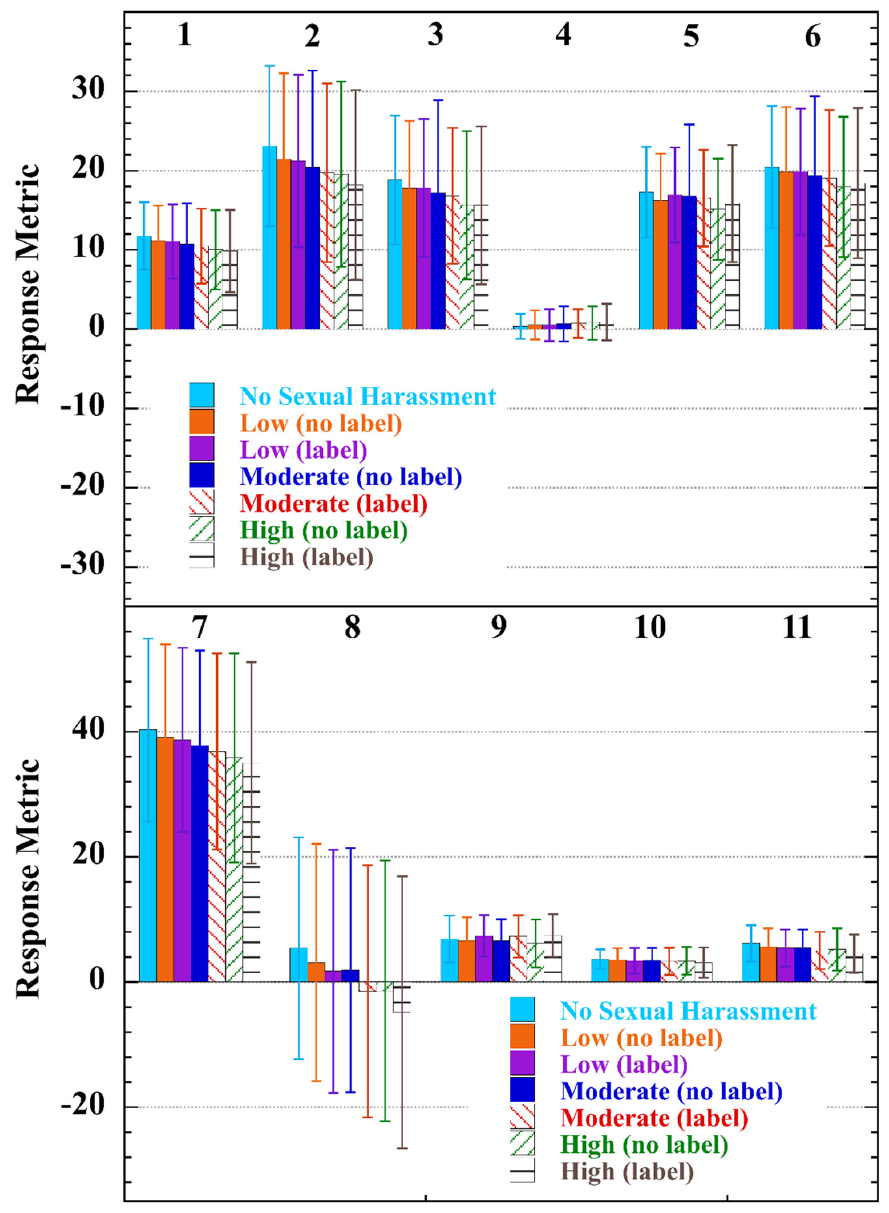
Figure 5. Psychological and work outcome variables among 22,305 military women in response to varying degrees of SEQ experiences, taken from Table 2 in Munson et al. [17] Variables are: 1, coworker satisfaction; 2, supervisor satisfaction; 3, psychological well-being; 4, emotional effects; 5, health satisfaction; 6, work group cohesiveness; 7, organizational commitment; 8, climate intolerant of sexual harassment; 9, attitudes toward sexual harassment; 10, amount of training; and 11, training effectiveness. The whiskers are ±2 σ , equivalent to 95% of the response variability among individuals.